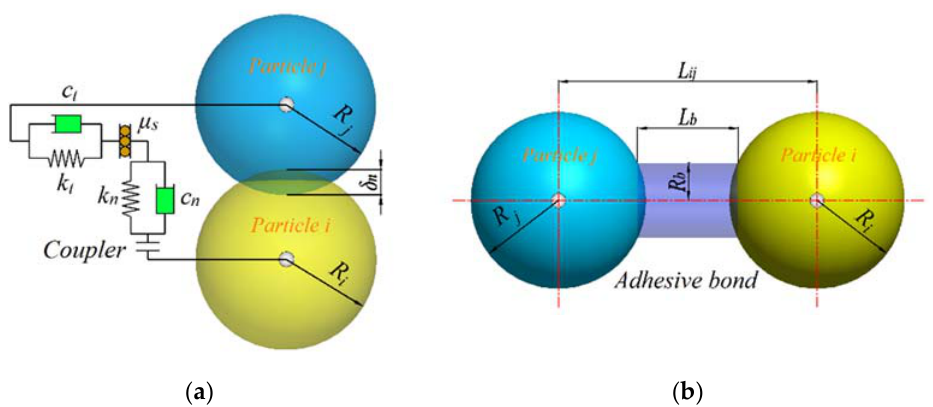
Figure 6. Contact model. ( a ) Two particles contact force model; ( b ) two particles connected by an adhesive bond.